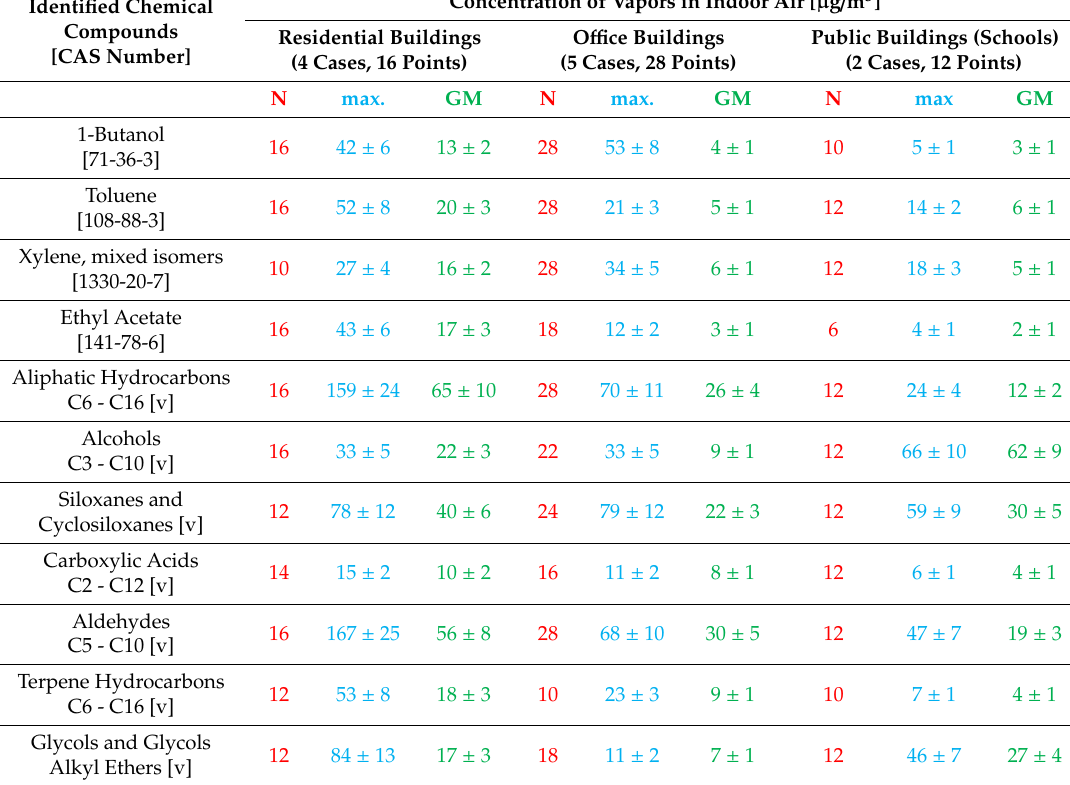
Table 2. Concentration of vapors of VOCs in the indoor air of buildings. The results were collated for 56 measuring points in 11 reference buildings, which were divided according to their purpose and